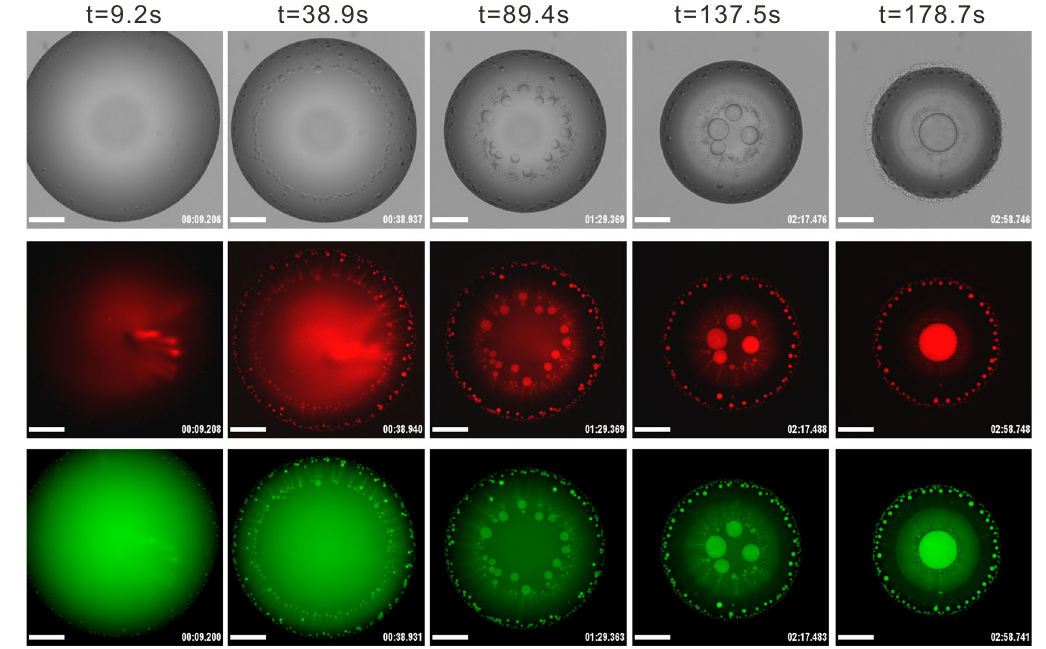
Fig. 3 Compartmentalization and localization of DNA inside the evaporating droplet. DNA localizes into dextran-rich compartments inside the evaporating sessile droplet. DNA is labeled with Cy-5 (red) and dextran-rich compartments are labeled with FITC-dextran (green). The ATPS solution is made up of 9 wt% PEG and 4 wt% dextran, with the addition of Cy-5 labeled DNA (10 µ M) and FITC-dextran ( M w ¼ 4000 ; 0.5 wt%). Images are obtained over analysis of seven independent trials with relative humidity ranging from 55 to 65%. The scale bar is 500 μ m.